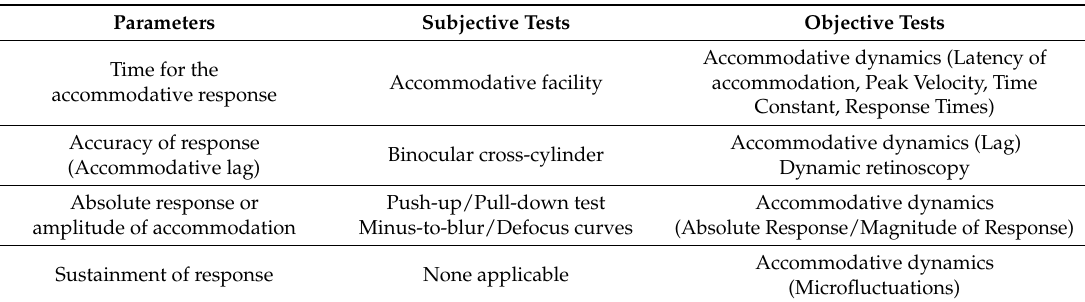
Table 1. The comparable subjective and objective tests for assessing the different parameters of accommodative